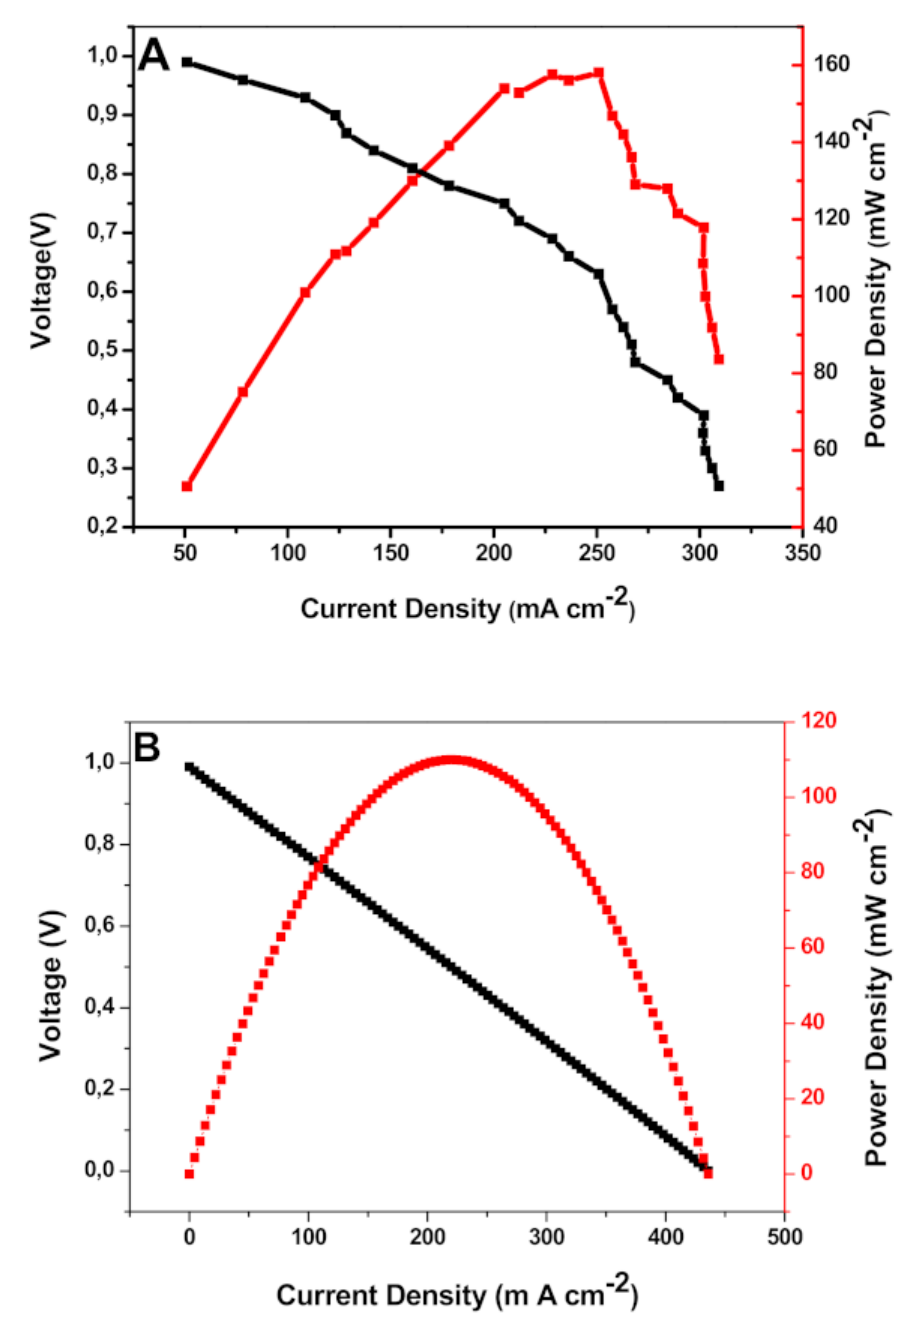
Figure 10. Polarization curves of ( A ) ImPPO/ZIF-8 and ( B ) commercial AEM using DMAFC at room